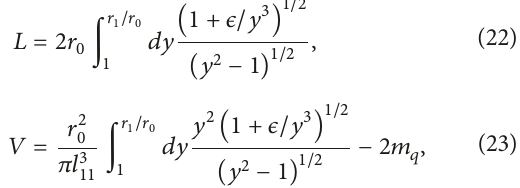
Table 2: Some values of 𝑟 ∗ /𝑅 2 in (20) for different values of the cutoff 𝑟 1 /𝑅 2 . Ideally, we should let 𝑟 1 /𝑅 2 → ∞ for the M2 branes. 𝑟 ∗ /𝑅 2 0.500 1 × 10 4 0.503 8 × 10 3 0.510